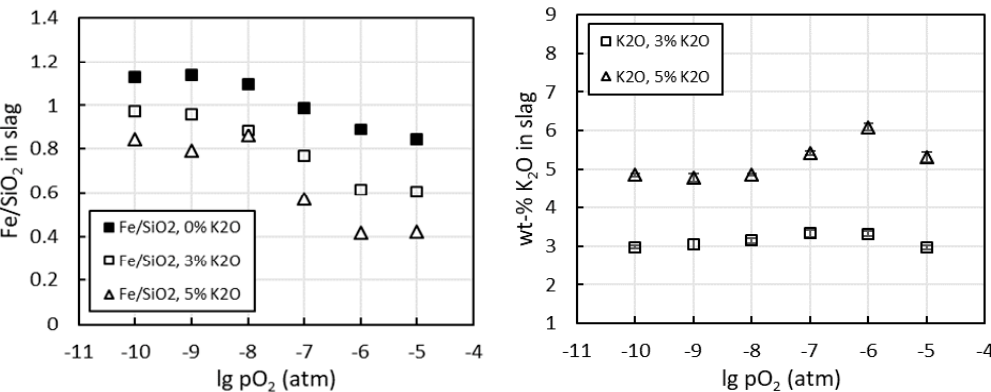
Figure 4. Left side: Fe/SiO 2 ratio in slags after equilibration. Right side: K 2 O concentration in slags as a function of oxygen partial pressure.